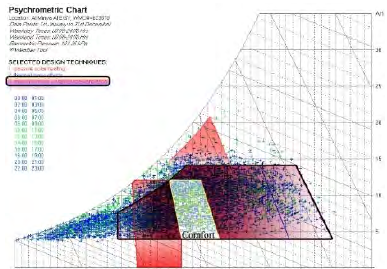
Figure 3. Psychometric Analysis for Al Minya City, showing hourly weather data and the small comfort area, and extreme high and low temperatures. The exposed mass + night purge ventilation will expand the comfort area to a wider range. Other actions have lower effects on covering the discomfort range.